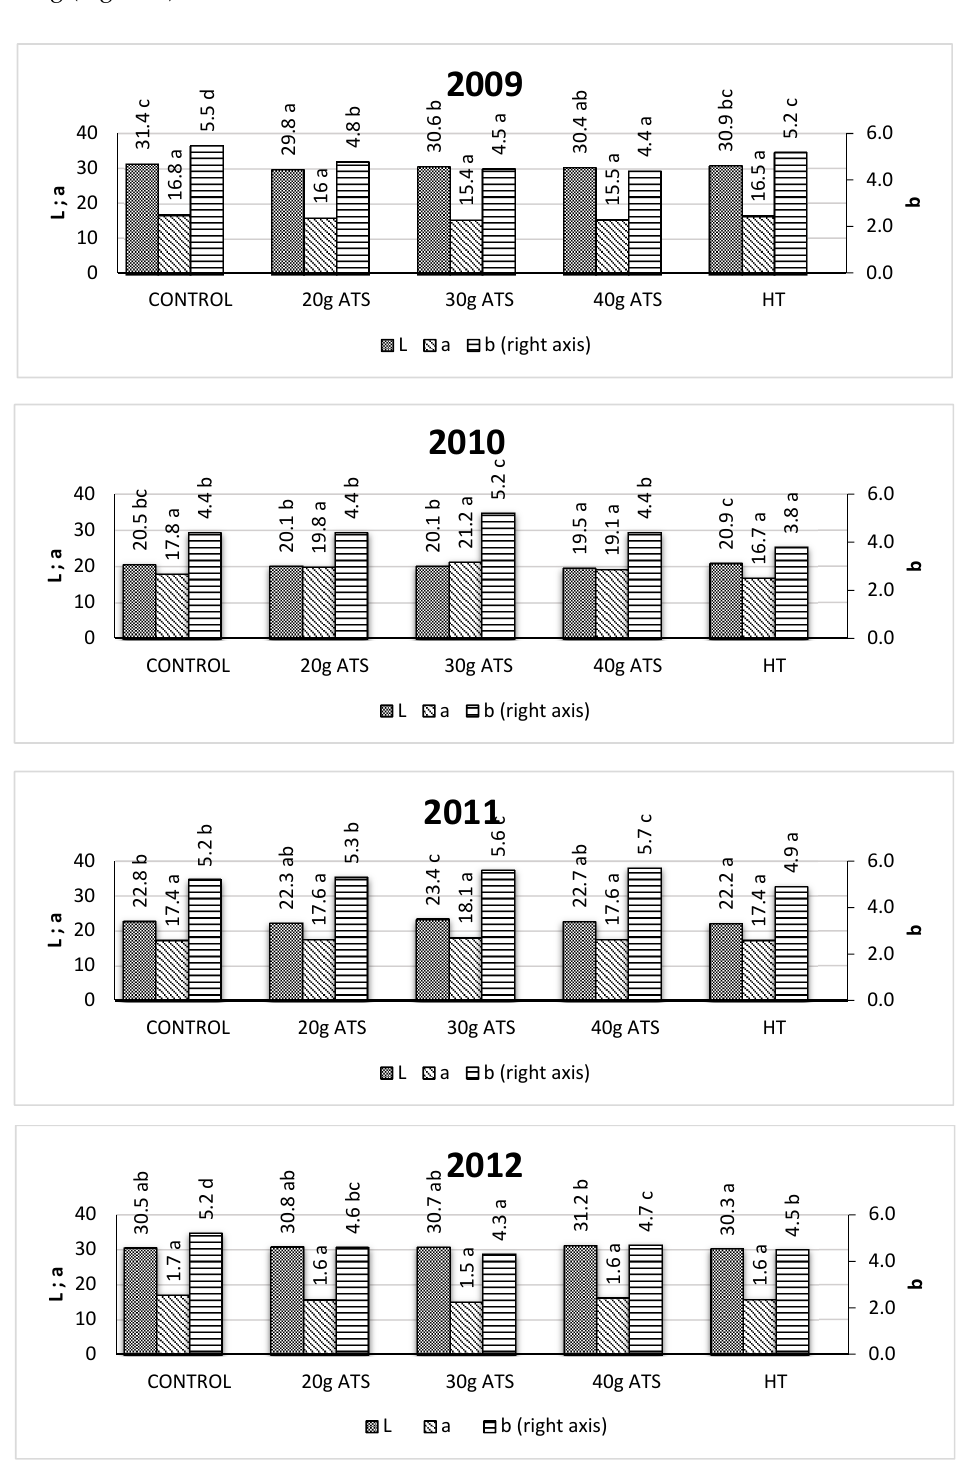
Figure 9. The effect of thinning on the colour of ‘Regina’ sweet cherry fruit in 2009, 2010, 2011 and 2012. 1 One-way analyses of variance separate for each colour coordinate; data in bars filled with the same pattern, marked with the same letter, are not significantly different at α = 0.05 (Duncan’s test). The hue value (h°) was not influenced by thinning in any of the analysed years (Table 5). The correlation coefficient between h° and TSS was negative ( − 0.89) regardless of year and treatment (Figure 10). Table 5. The effect of thinning on the hue value (h°) of ‘Regina’ sweet cherry fruit—mean values for